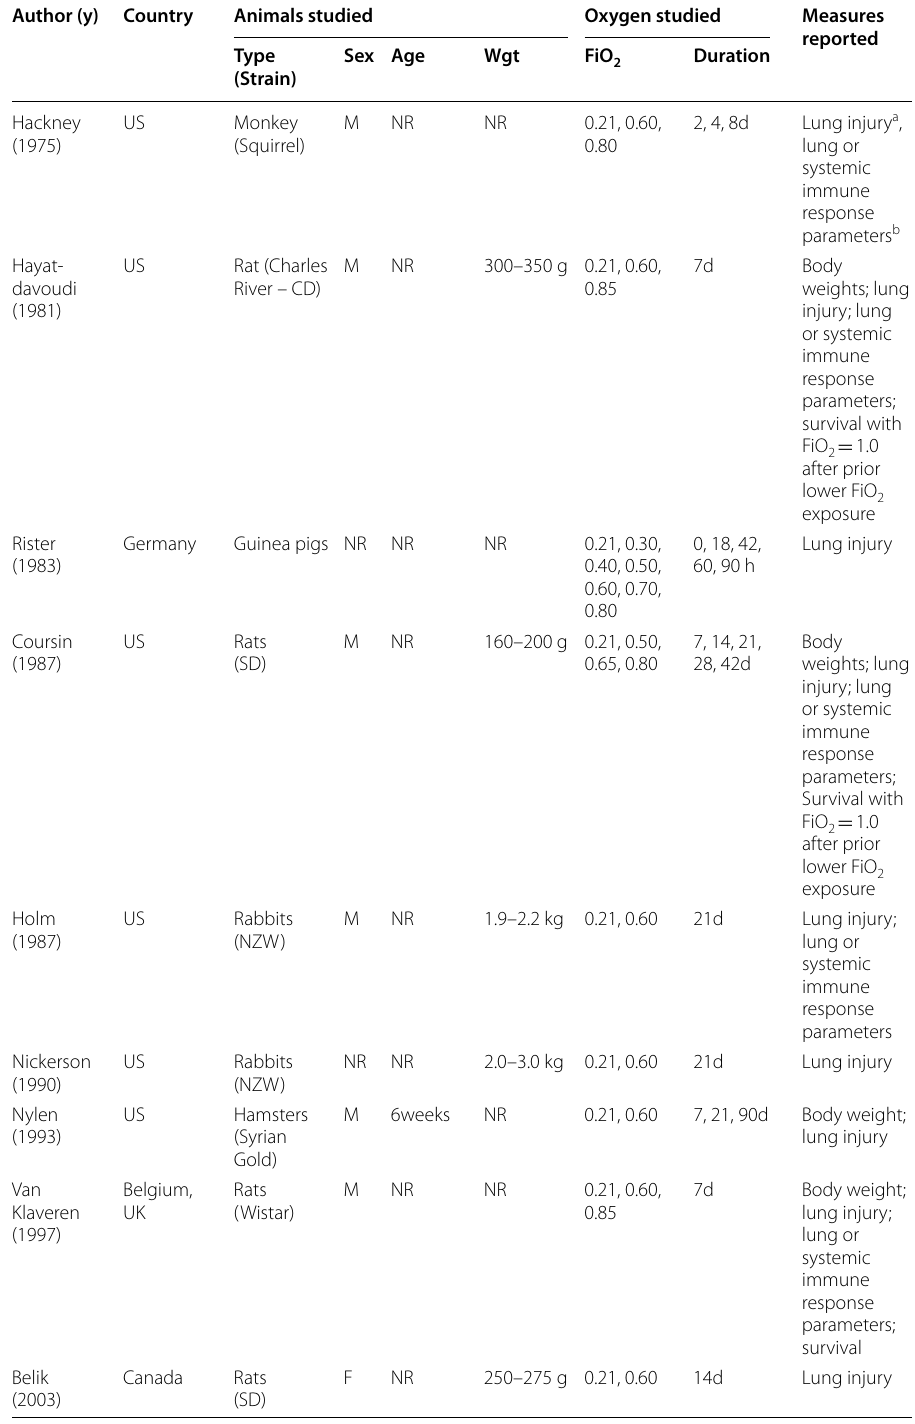
only study characteristics 2